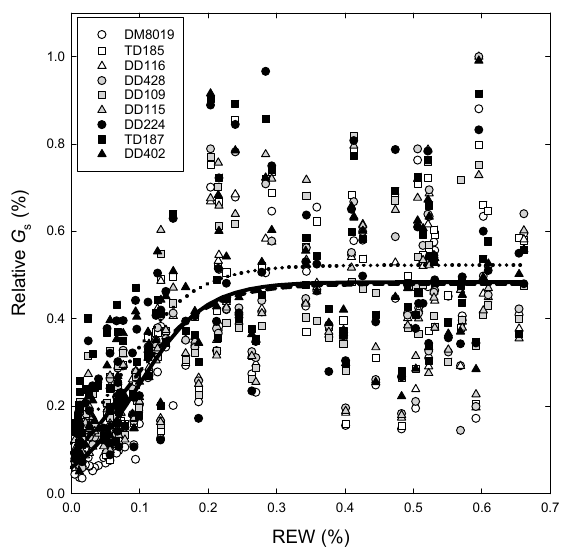
Figure 6. The relationship between normalized canopy conductance ( G s, %), relative to maximum G s, measured during a 102 day period (DOY 153–255), and relative extractable water (REW) in P. deltoides (DD), P. trichocarpa × deltoides (TD), and P. deltoides × maximowiczii (DM) clones. Open, light shaded, and dark shaded symbols represent high (Group H), intermediate (Group I), and low (Group L) productivity genotypes, respectively. Solid, dashed and dotted lines represent regression fits for the logistic model y = c / (1 + a × exp( − b × REW) for Group H, I, and L, respectively. Average daily G s (PAR > 800) was partitioned into dry (REW < 0.20) and wet (REW > 0.30) periods, to examine the sensitivity of G s to D (Equation (2)). The model was fit to each tree, where the sample size was 969 and 654 observations per tree, for dry and wet periods, respectively. Slopes